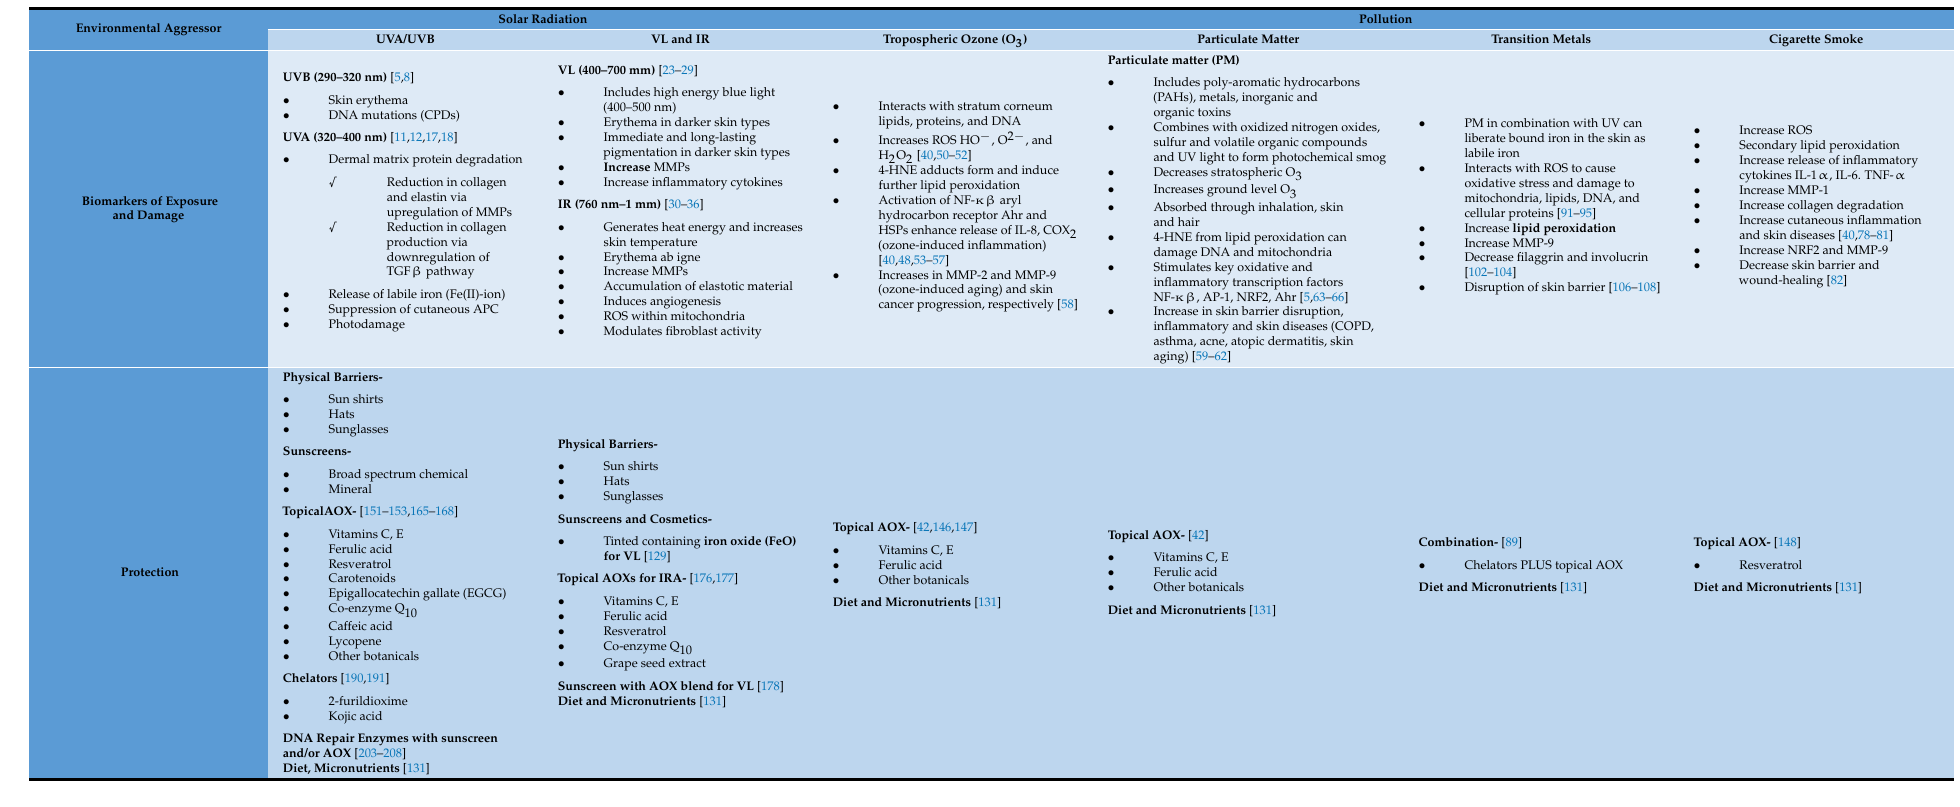
Table 1. Cutaneous stressors, skin damage and protection